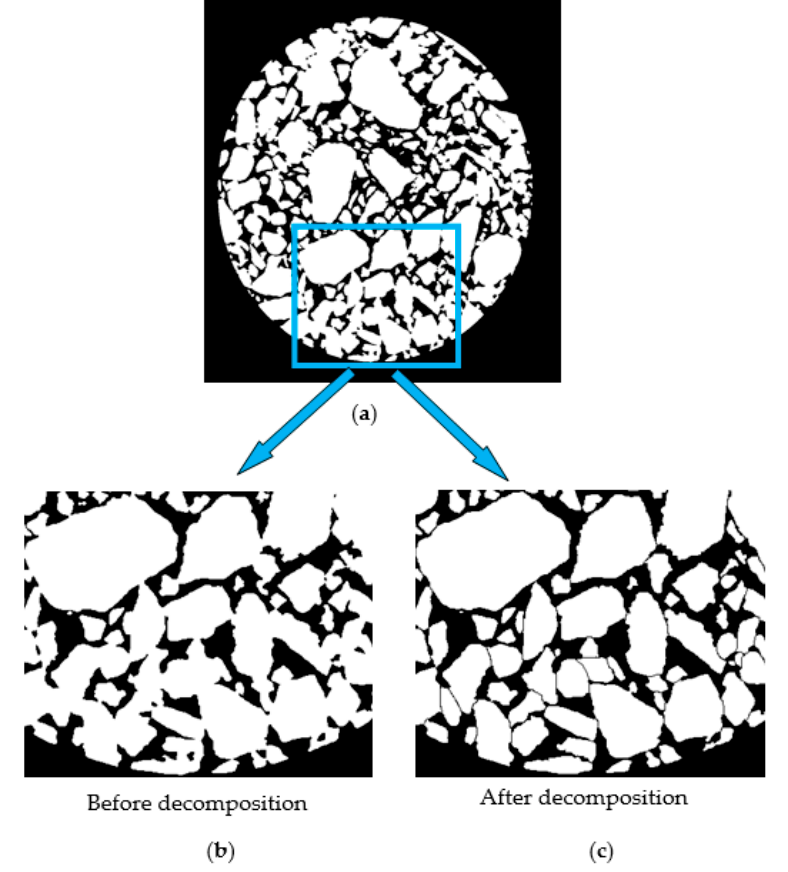
Figure 7. Image segmentation after morphological multiscale decomposition: ( a ) binary image; ( b ) image before decomposition; and ( c ) image before decomposition.